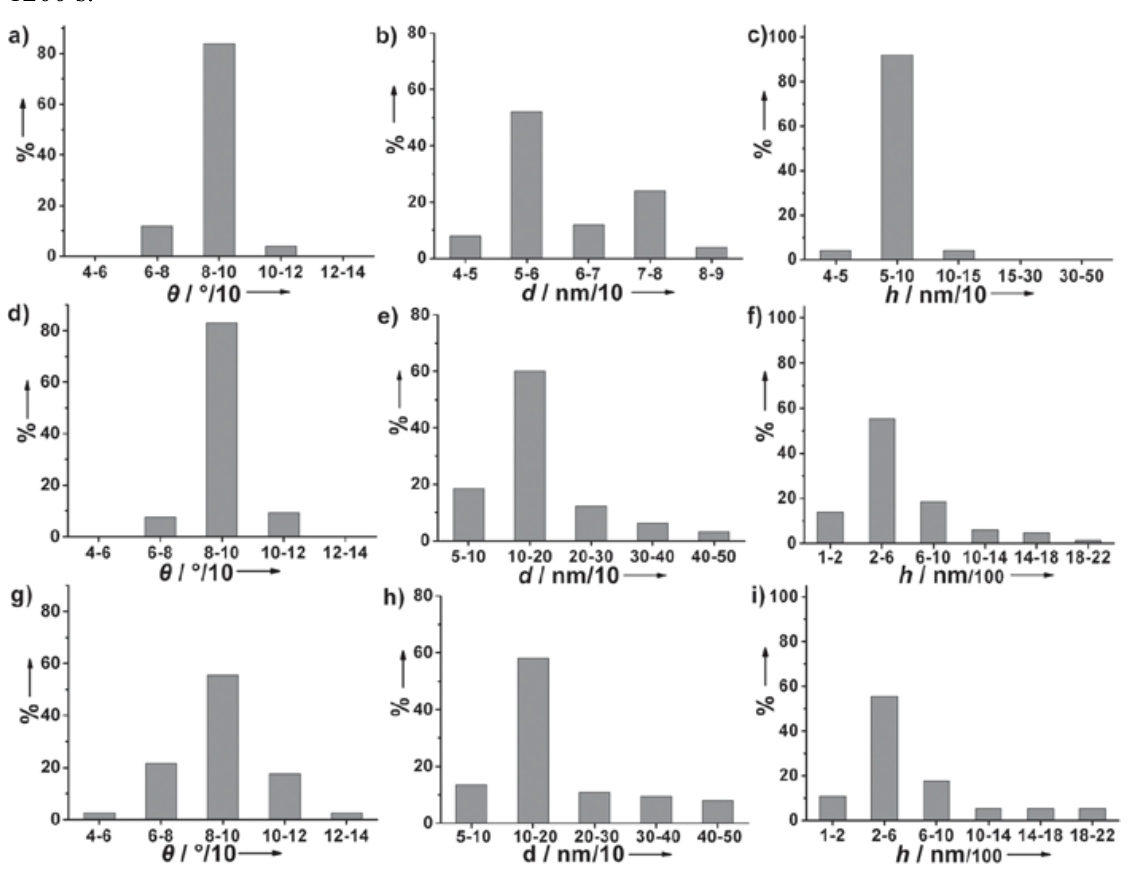
Figure 3. Distribution of angles, diameters and heights of Au nanostructures electrodeposited at -0.2 V for different time intervals: (a, b, c) 400 s, (d, e, f) 800 s, (g, h, i) 1200